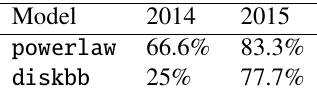
Table 2. Well-fitted data